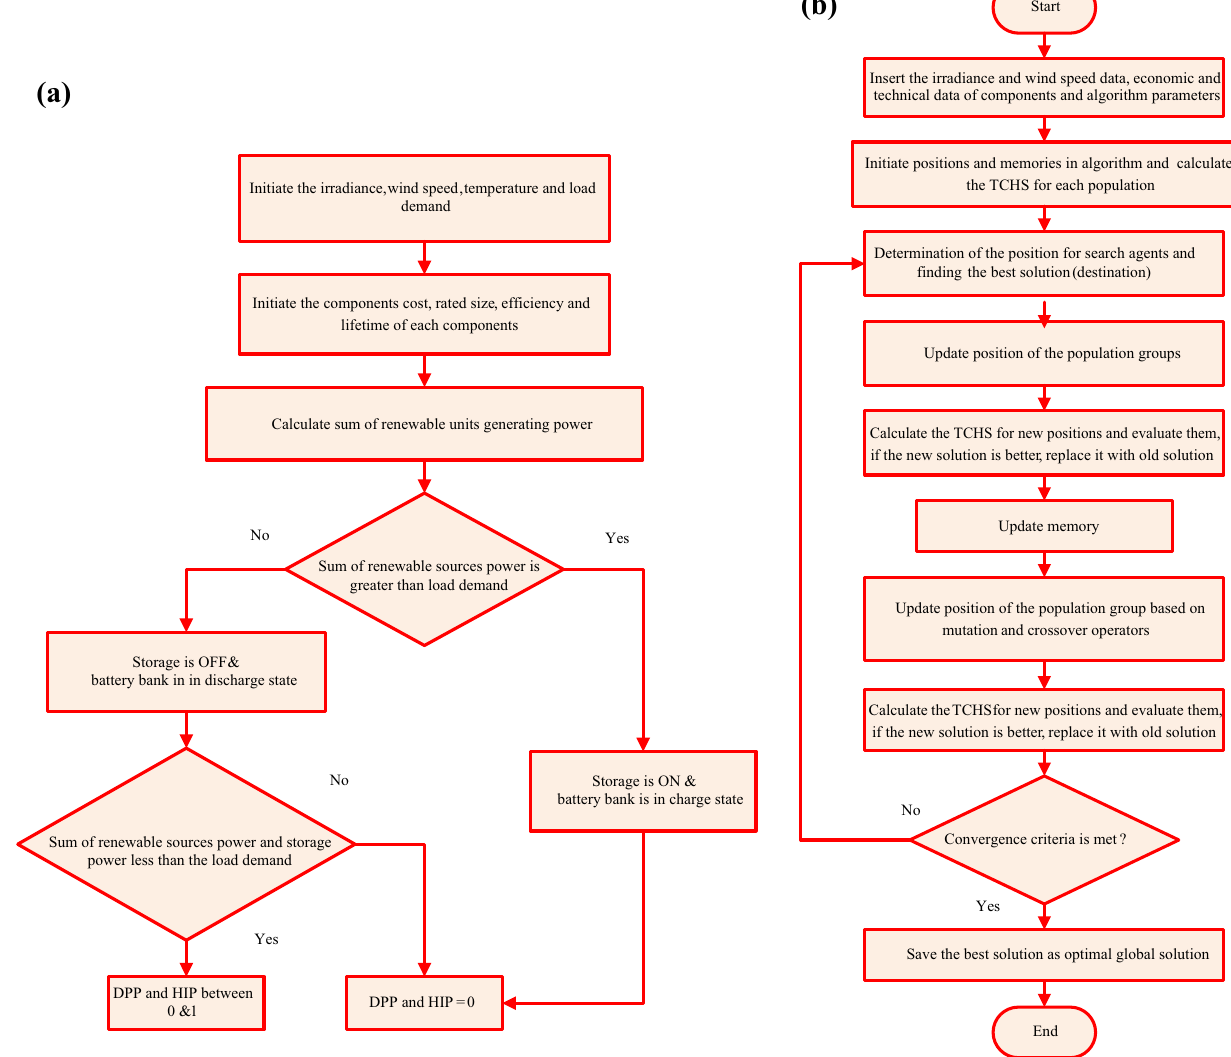
Fig. 2 a Battery storage operation and b flowchart of hybrid PV/WT/Batt design Table 1 Parameters of hybrid PV/WT/Batt system components [14,